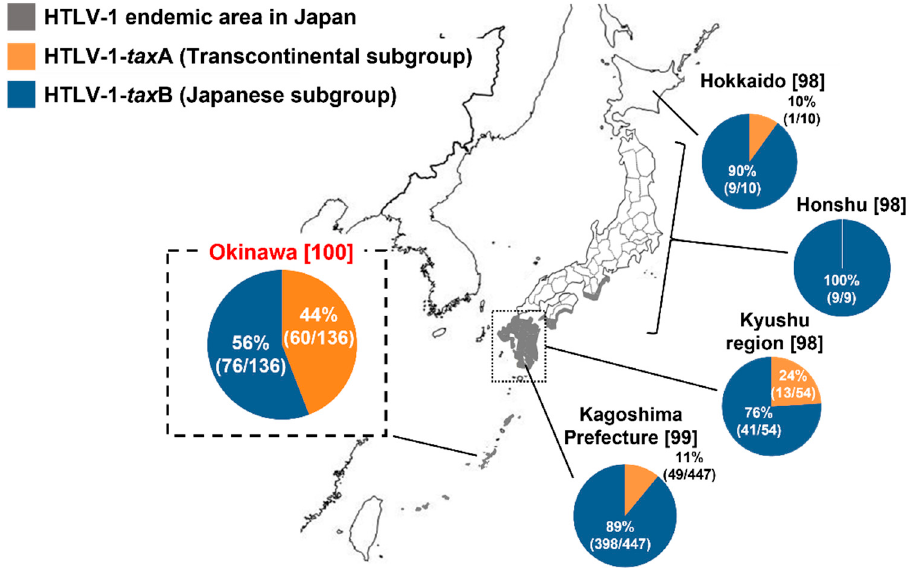
Figure 5. Distributions of HTLV-1 strains in Japan described in previous reports